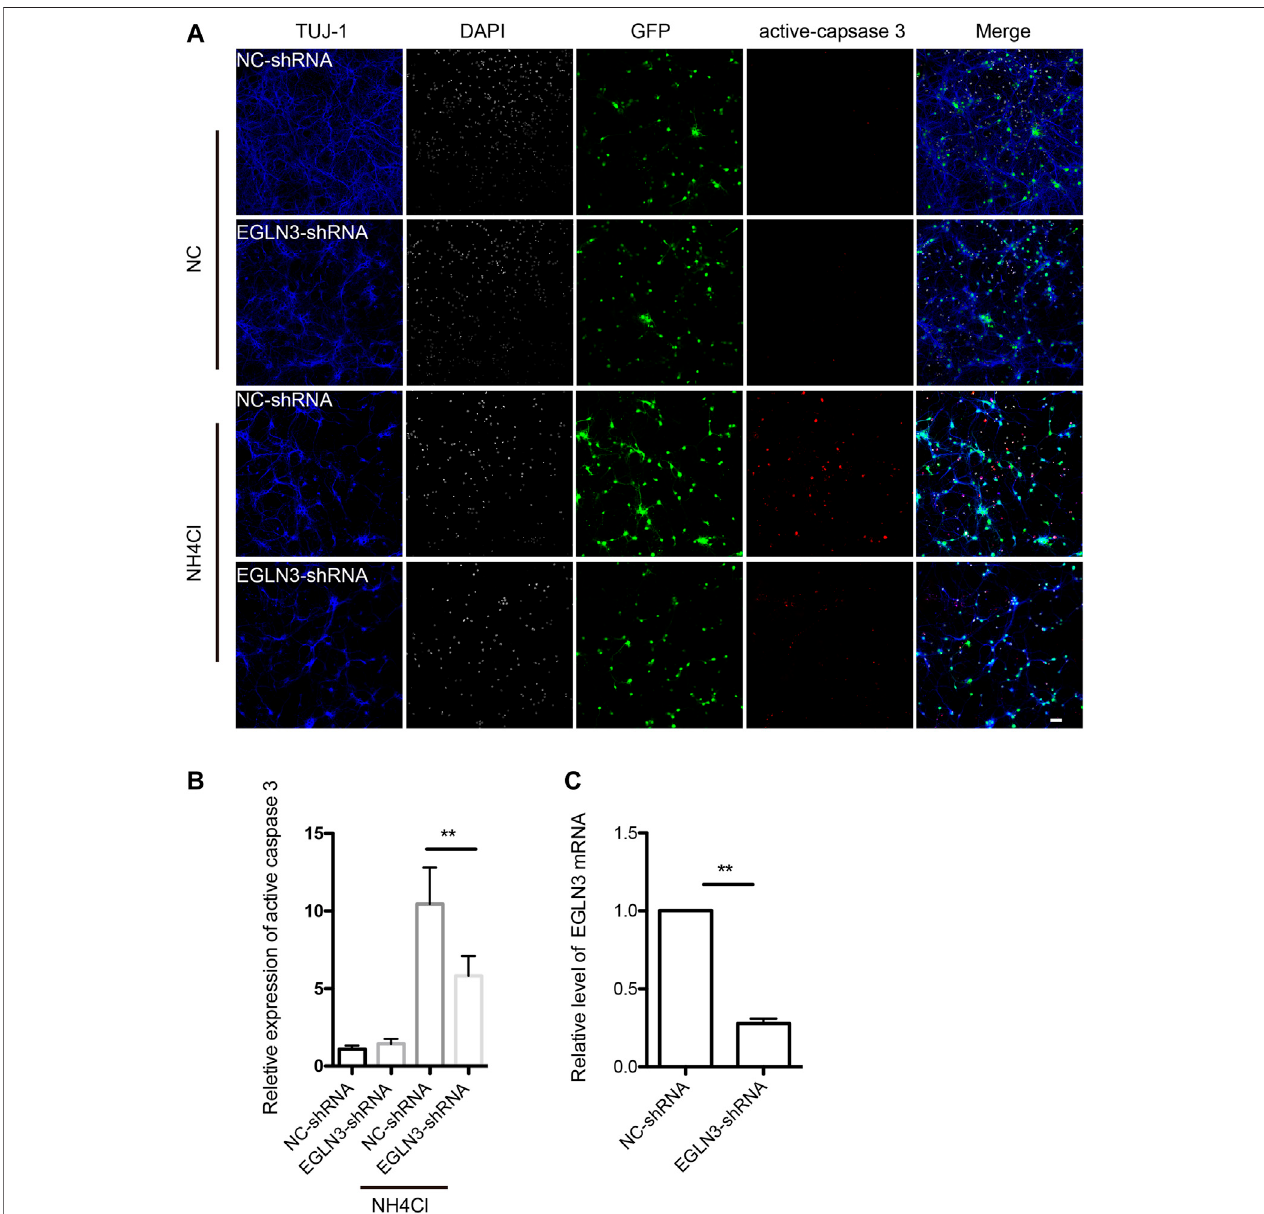
FIGURE 4 | EGLN3 knockdown decreased ammonia-induced neuronal apoptosis.Neurons were infected with shRNA lentivirus (GFP green) targeting EGLN3 or control shRNA lentivirus and subjected to ammonia treatment. (A) Immuno fl uorescent stain using antibodies against neuron-speci fi c β -tubulin TUJ 1 (blue color), activated caspase-3 (red color), and counterstain with 4,6-diamidino-2-phenylindole (white color) to show nuclei revealed EGLN3 inhibition decreased activated caspase-3 expression during ammonia treatment. (B) Quantitation (mean ± SEM) of (A) from three independent experiments. Ammonia induced activated caspase-3 expression was attenuated by EGLN3 knocked-down. (C) EGLN3 knockdown ef fi ciency was validated by quantitative real-time PCR. ** p < 0.01. bar = 10 µm.